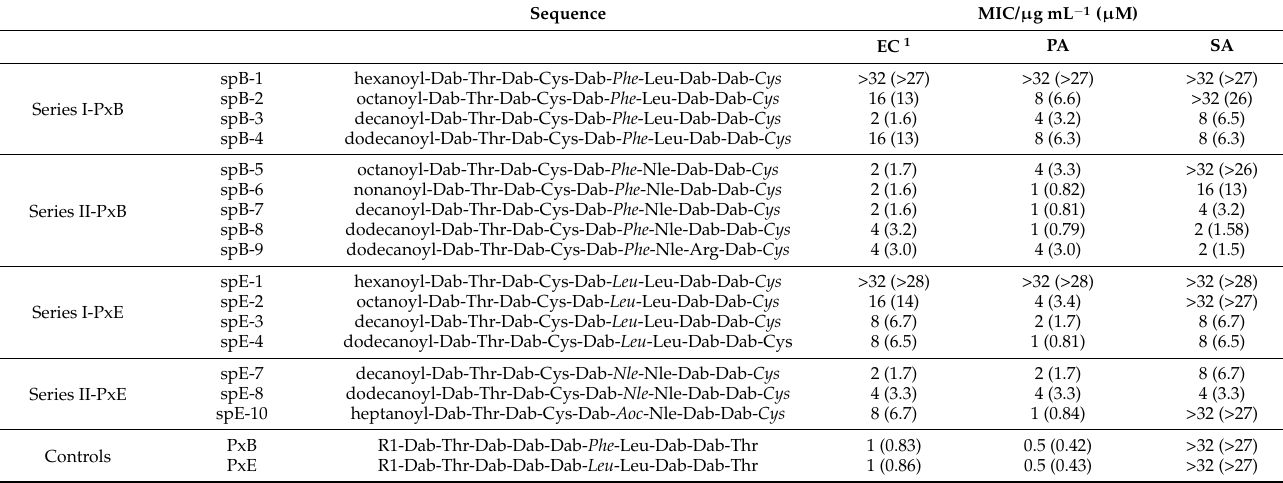
Table 1. Sequences and antimicrobial activities of the synthesized peptides determined as minimal inhibitory concentration (MIC) calculated for different bacteria